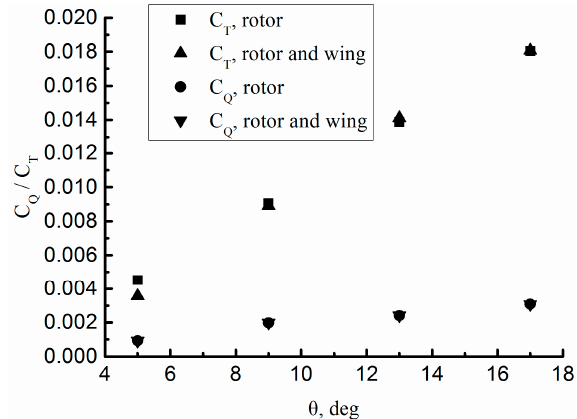
Figure 6. Predicted rotor thrust and torque coefficients for the isolated rotor and wing–rotor cases.